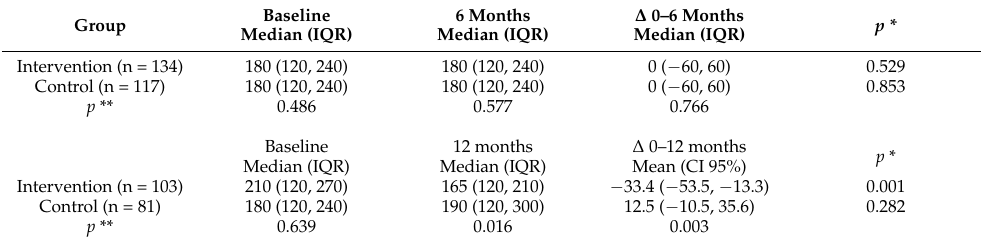
Table 3. Change in screen time (min/d) at 6- and 12-month follow-ups, according to the study